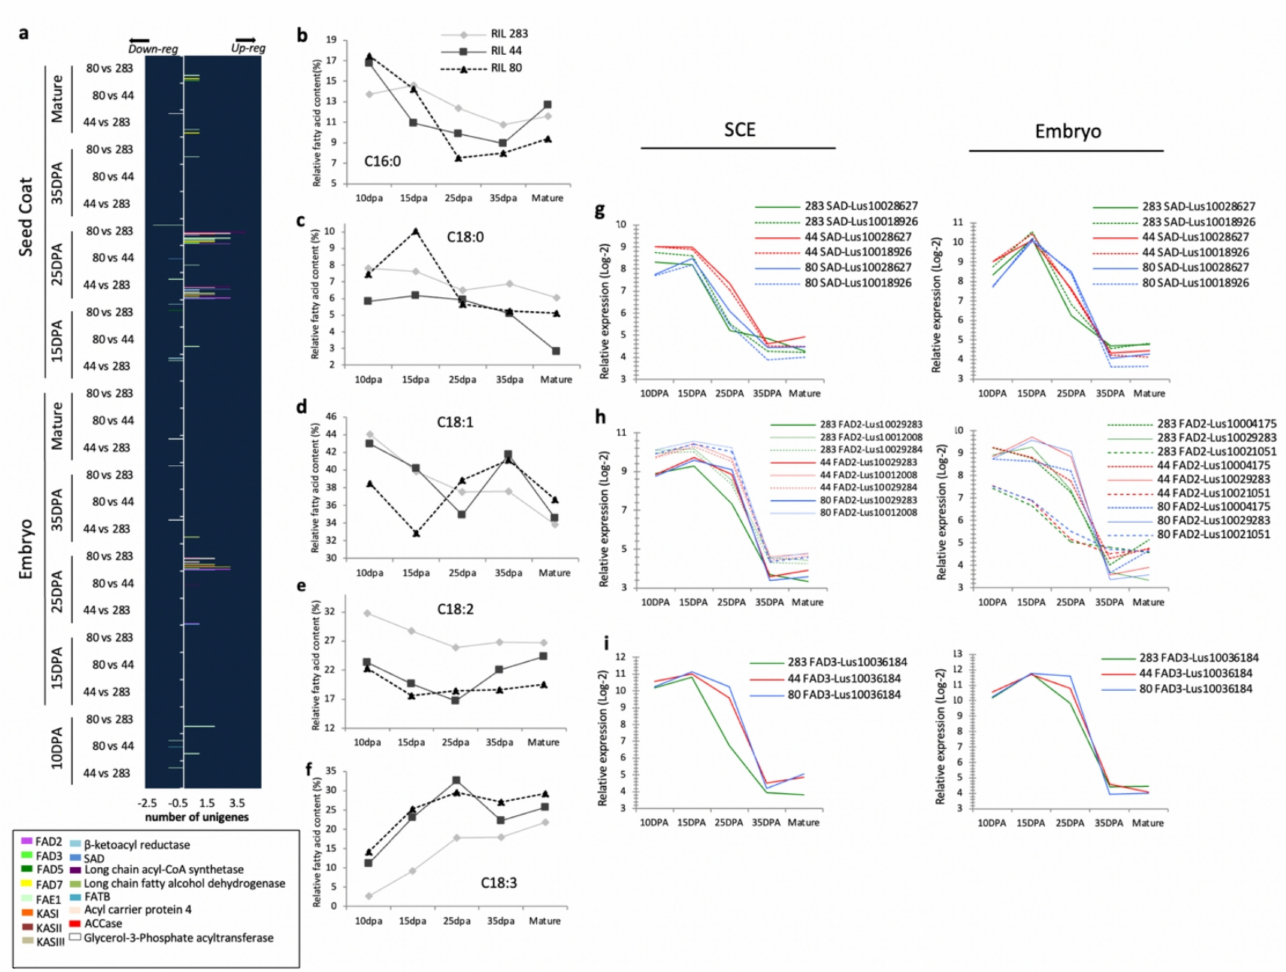
Figure 5. Analysis of the transcriptional regulations of the FA and seed oil metabolisms in flax RILs during seed development. ( a ) Histogram showing the number of unique and overlapping differentially expressed genes from pairwise comparison analysis of the three RILs. Genes are classified in sixteen different categories according to their putative roles in FA and seed oil metabolism based on literature. ( b – f ) FA accumulation profiles in the embryo of the three RILs. ( g – i ) Expression patterns of the genes involved in FA and seed oil metabolism and corresponding to the main fatty acid desaturases; i.e., SAD ( g ), FAD2 ( h ) and FAD3 ( i ). To facilitate data visualization, the expression patterns were displayed separately for the SCE (left) and the embryo (right). Expression patterns of genes of RIL 283, RIL 44 and RIL 80 are respectively represented in green, red and blue. For each one, the corresponding parallel coordinates plot displays the relative gene signal intensity according to the stages of development. The relative signal intensity represents the lsmean (Log2 transformed) of the raw data extracted from the oligo microarrays analysis. Data are lsmeans of three biological replicates. Each of the genes are associated with their corresponding